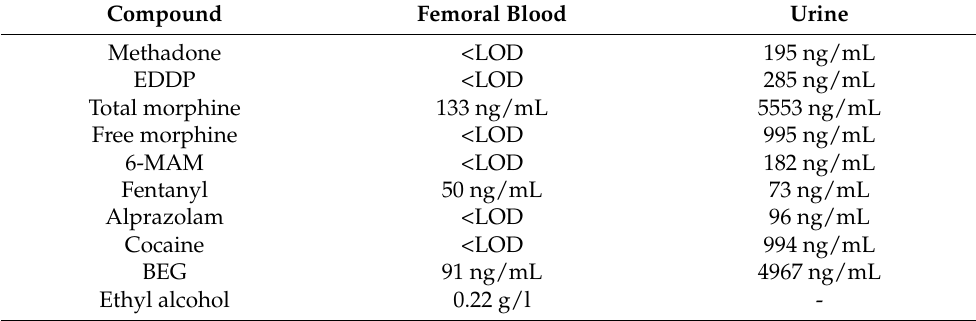
Table 2. Results of toxicological